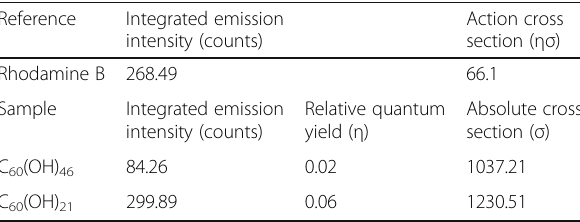
Table 3 TPE cross section of materials (Ex, 760 nm)